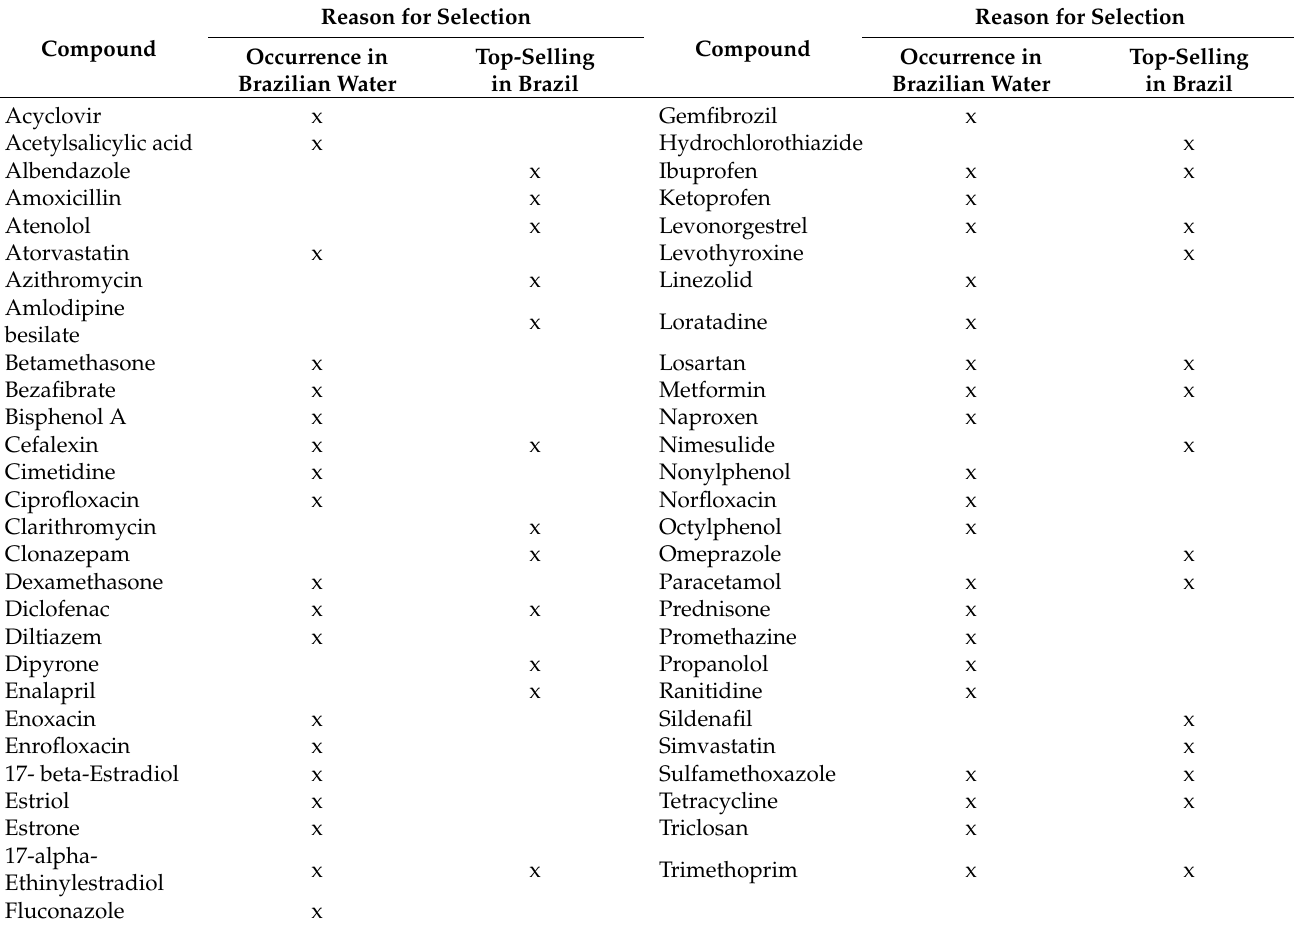
Table 2. Pharmaceuticals and endocrine disrupting compounds (P&EDC) selected for further risk assessment.